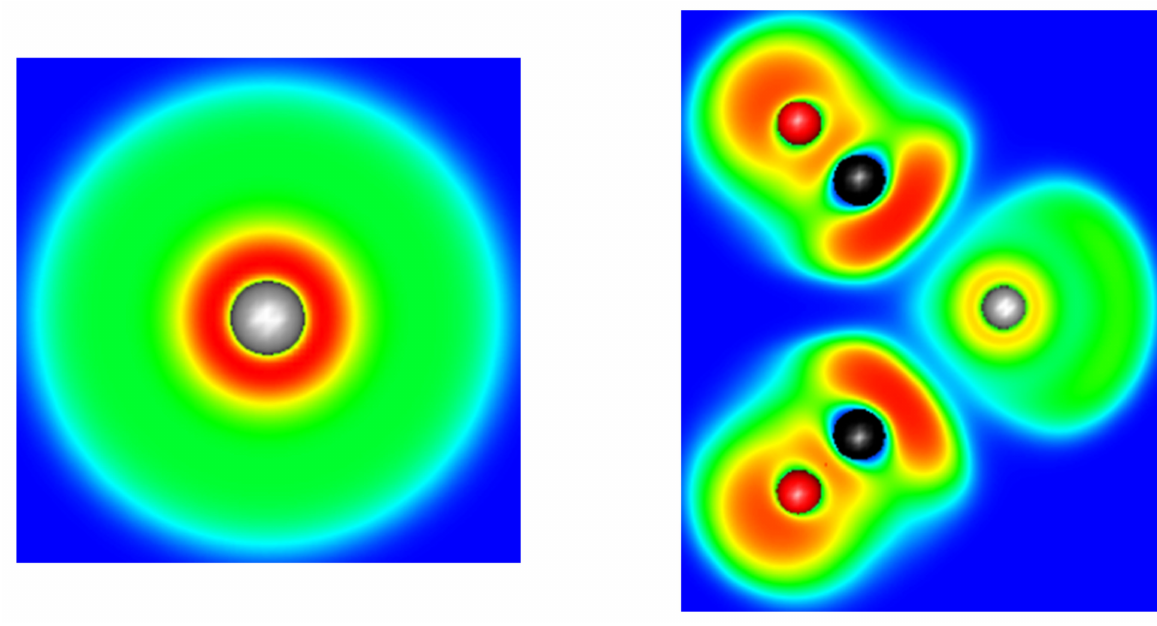
Figure 4. Cut plane of the ELF function of an isolated Pb 2+ cation ( left ) and along the σ v plane of the [Pb(CO) 2 ] 2+ complex ( right ). The range of the ELF functions varies from 0 (deep blue) to 1 (deep